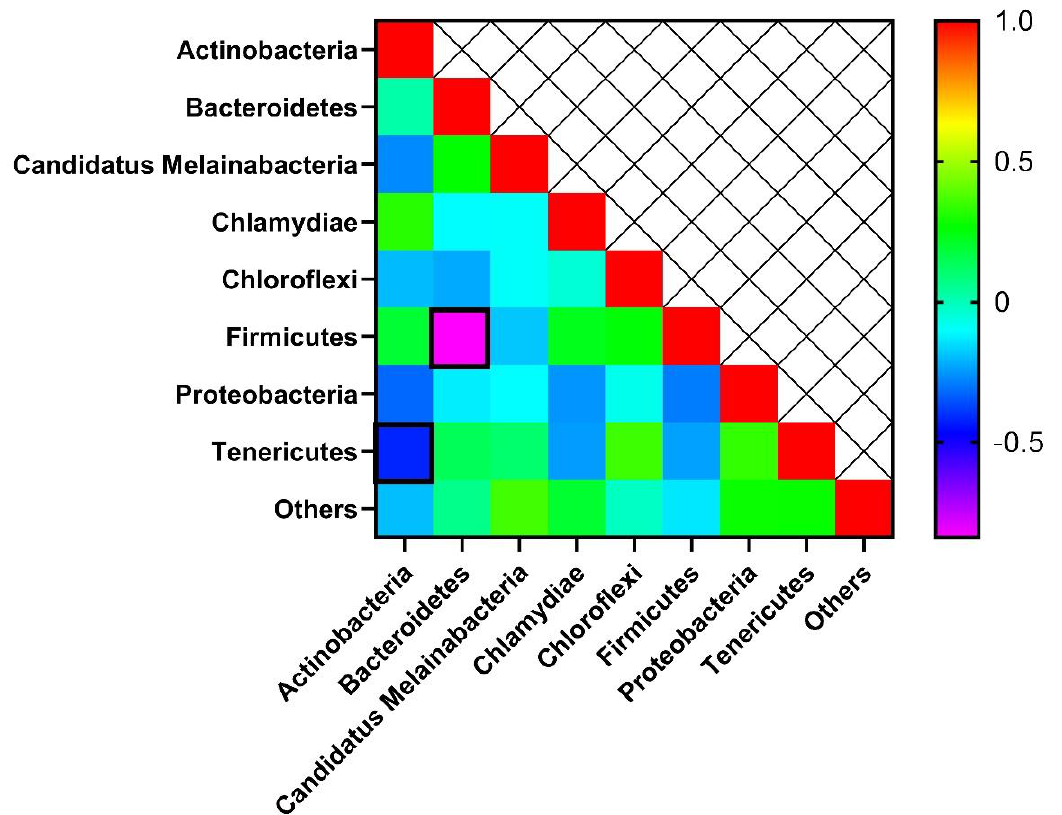
Figure 5. Cecum bacterial phyla correlation in broiler chickens. Zero represents similarity while plus and minus values represent positive and negative correlations, respectively. The square box outlined with black indicates significance at p < 0.05.